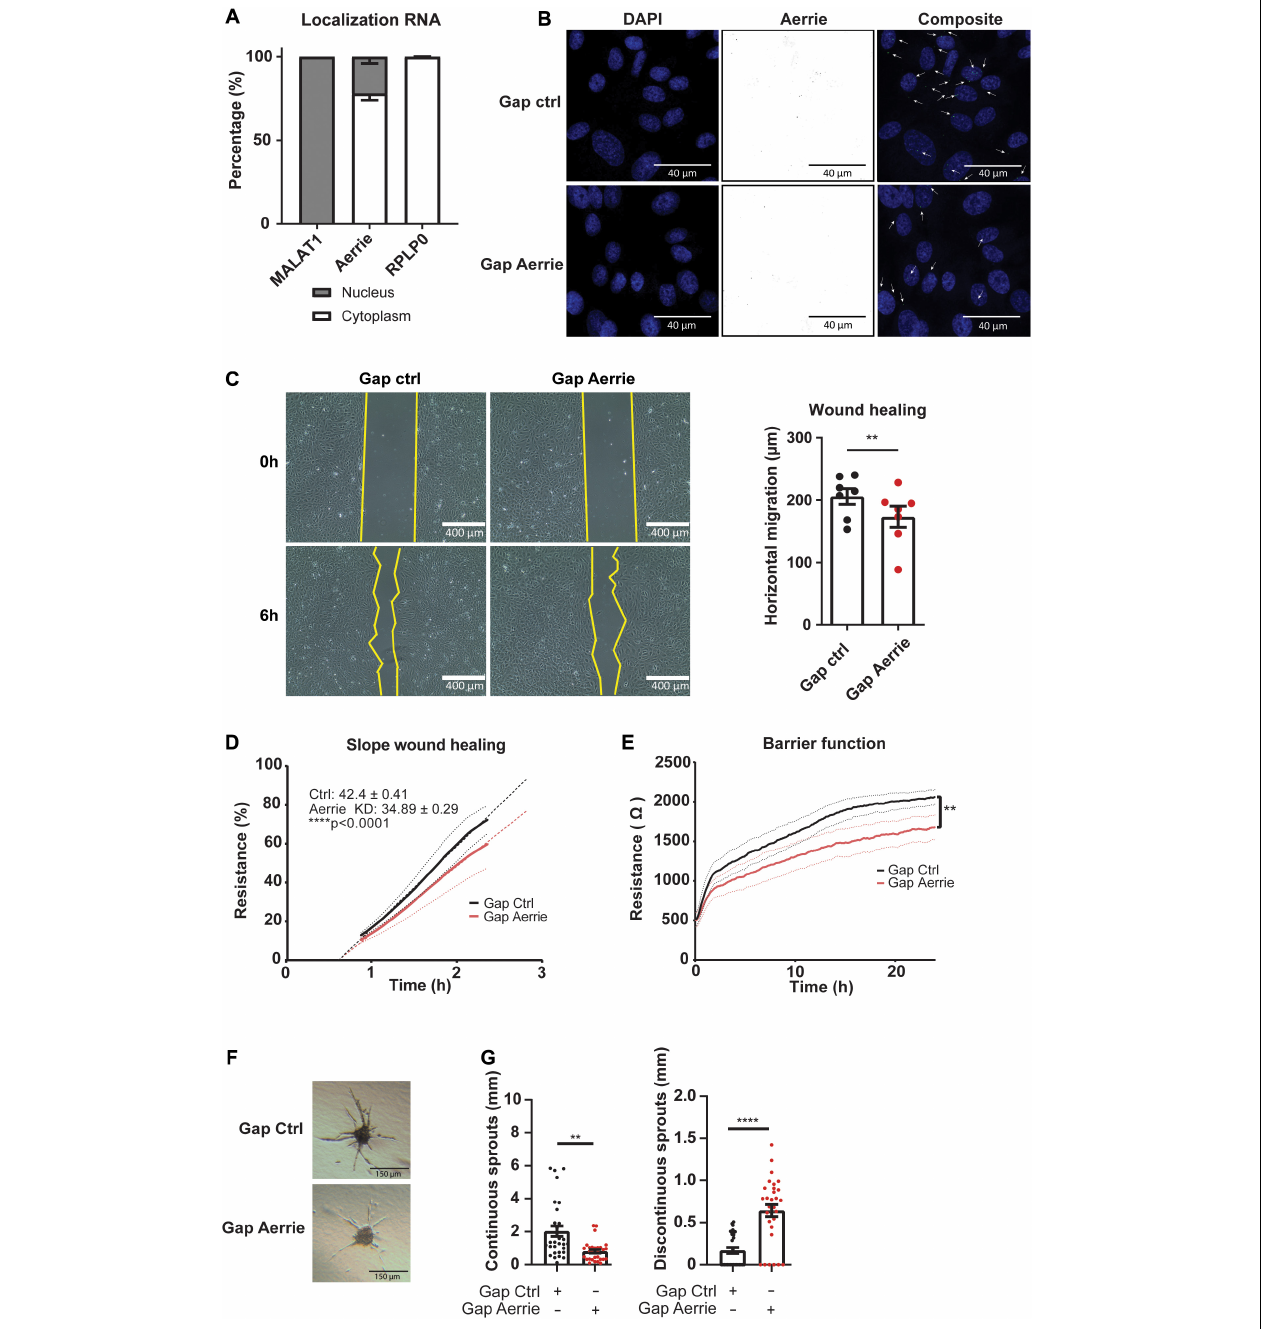
FIGURE 2 | The loss of Aerrie reduces migration, barrier function, and angiogenic sprouting in vitro . (A) HUVECs were fractionated into nucleus and cytoplasm. RT-qPCR was performed to measure lncRNA Aerrie localization. RPLP0 was used as cytoplasmatic control and lncRNA Malat1 as a nuclear control ( n = 3). (B–G) HUVECs were treated with gapmeR (gap) targeting Aerrie or a respective control. (B) Subcellular localization of Aerrie in HUVECs was analyzed by SCRINSHOT RNA FISH. Nuclei were visualized with DAPI. Arrows indicate Aerrie localization. HUVECS were visualized with DAPI on the 405 nm channel and Aerrie on the 488 nm channel. (C) Scratch assay was performed with HUVECs for 6 h. The horizontal migration is calculated by the change in surface area ( n = 7). (D) Electric cell-substrate impedance sensing (ECIS) was performed to measure migration of HUVECs. The endothelial monolayer was damaged through lethal electroporation. The recovery slope was determined between 1 to 2 h post wounding ( n = 3). (E) ECIS was performed to measure the barrier function of the endothelial monolayer. The resistance of the endothelial monolayer was determined after 24 h ( n = 3). (F) Brightfield images of silenced Aerrie sprouts and its control. (G) Cumulative sprout length was determined for continuous and discontinuous sprouts. ( n = 3, at least 10 spheroids were measured per experiment). Quantification of the discontinuous sprouts measured by the distance from the tip cell to the stalk cell. ** p < 0.01; **** p < 0.0001; ns , not statistically significant.